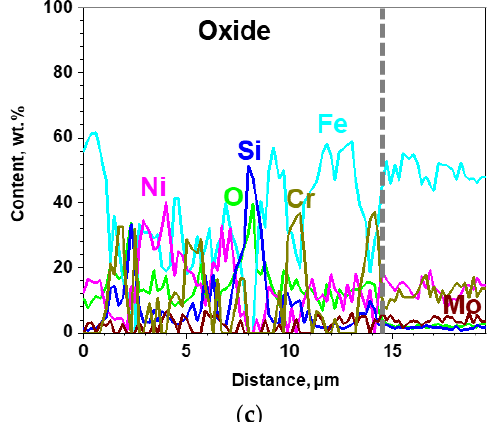
Figure 9. ( a ) Surface SEM, ( b ) cross-sectional BSE micrograph of the surface-modified SS 316LN after exposure to steam at 650 °C (0.1 MPa) for 500 h, and ( c ) result of EDS line scan along the dotted line in (b).